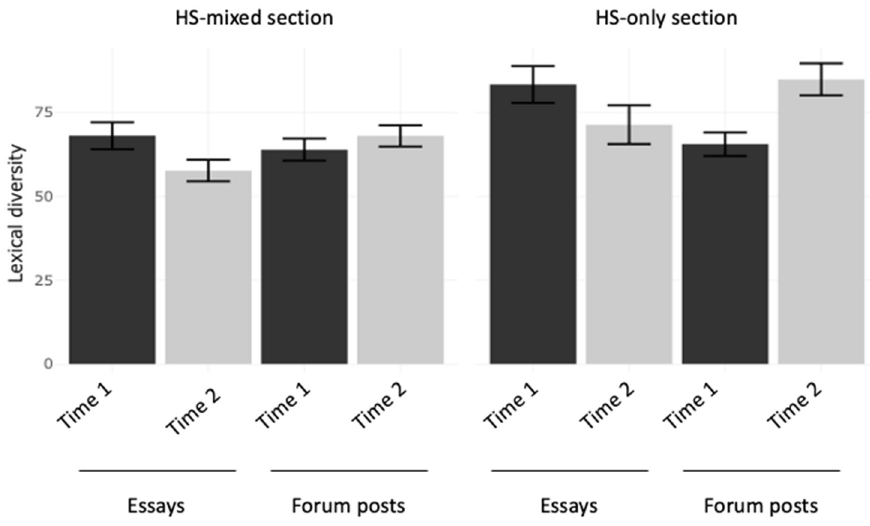
Figure 1. Lexical diversity by group, time, and type of assignment (means and SE).